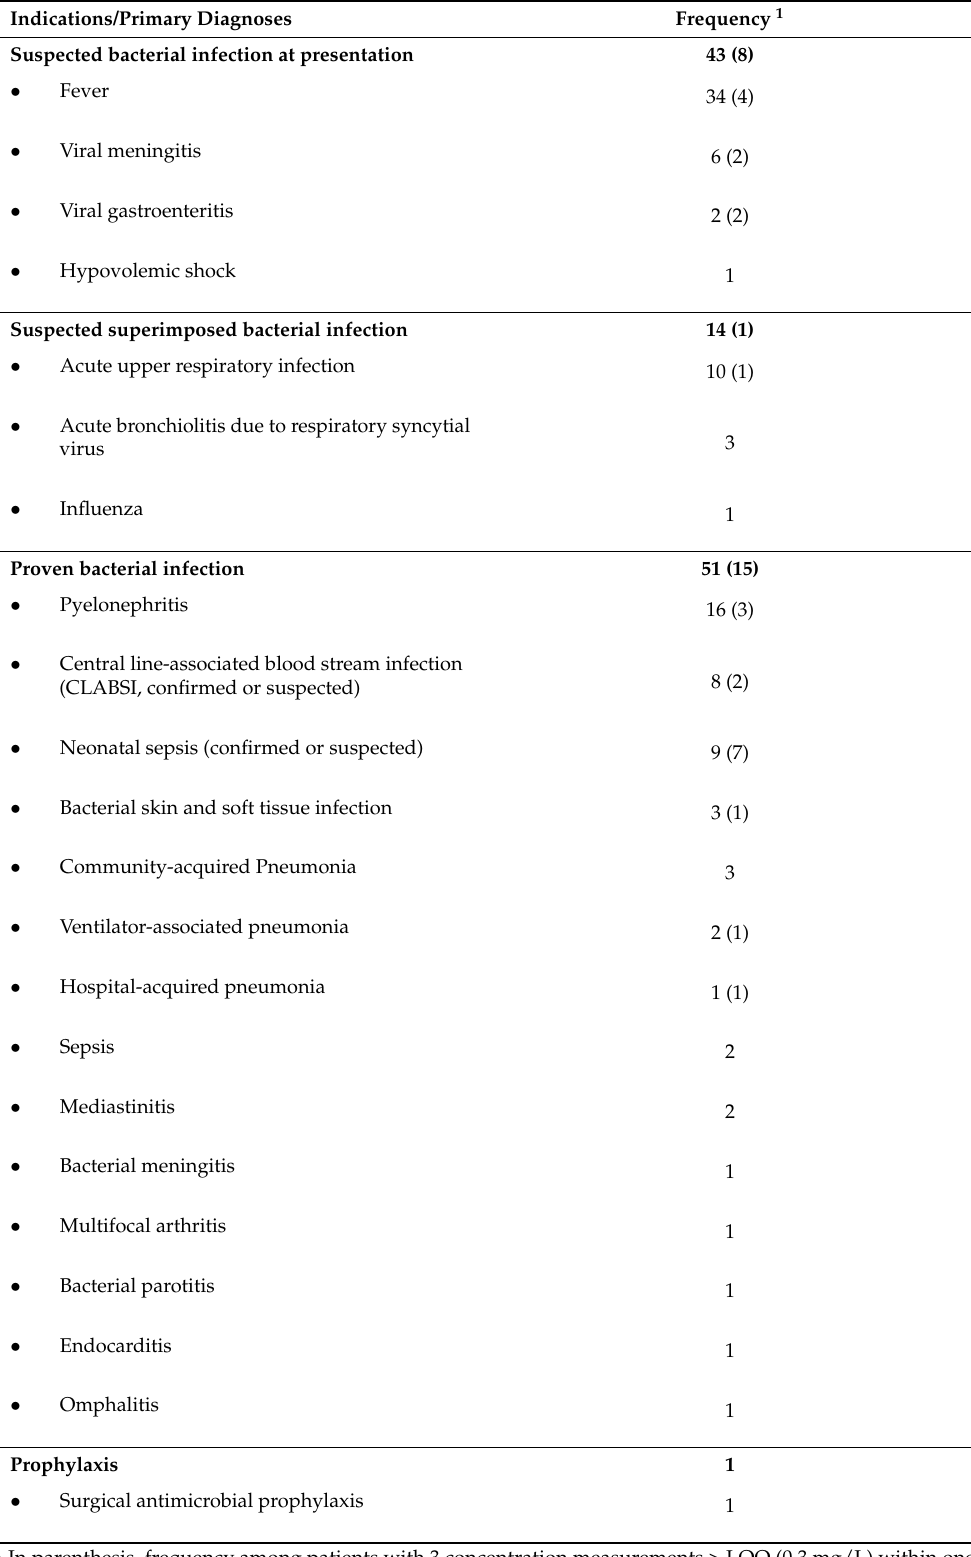
Table 2. Indications with primary diagnoses and their frequencies in the study